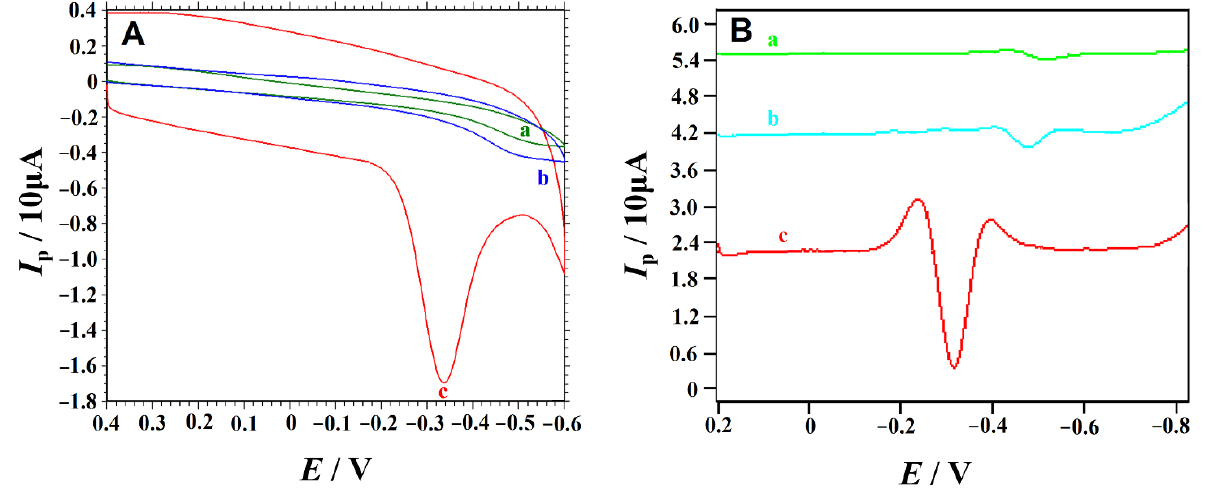
Figure 5. Cyclic voltammograms ( A ) and second derivative linear sweep voltammograms ( B ) of 0.1 mM 4-NP in 0.2 M H 2 SO 4 solution obtained at bare GCE (a), f-NC1/GCE (b) and f-NC2/GCE (c). Scan rate: 0.1 V s −1 .